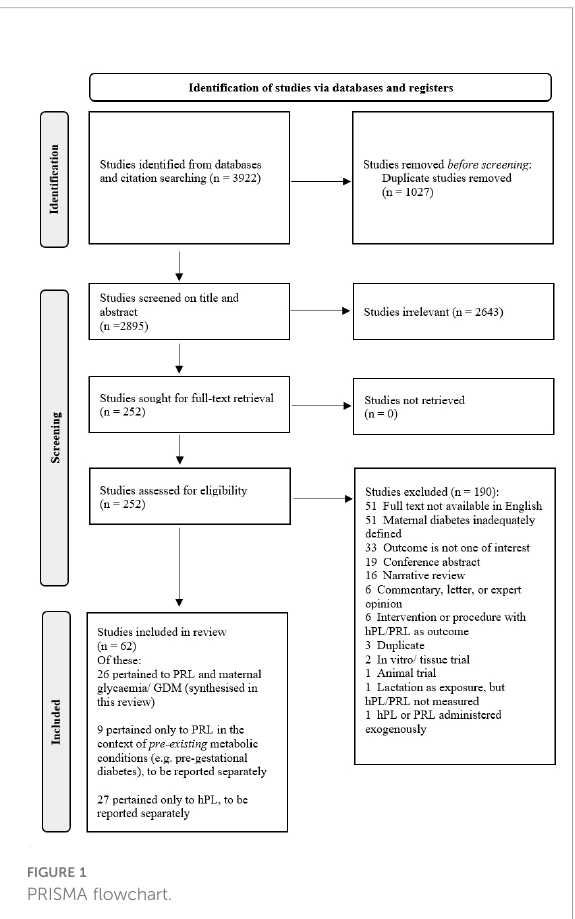
FIGURE 1 PRISMA fl